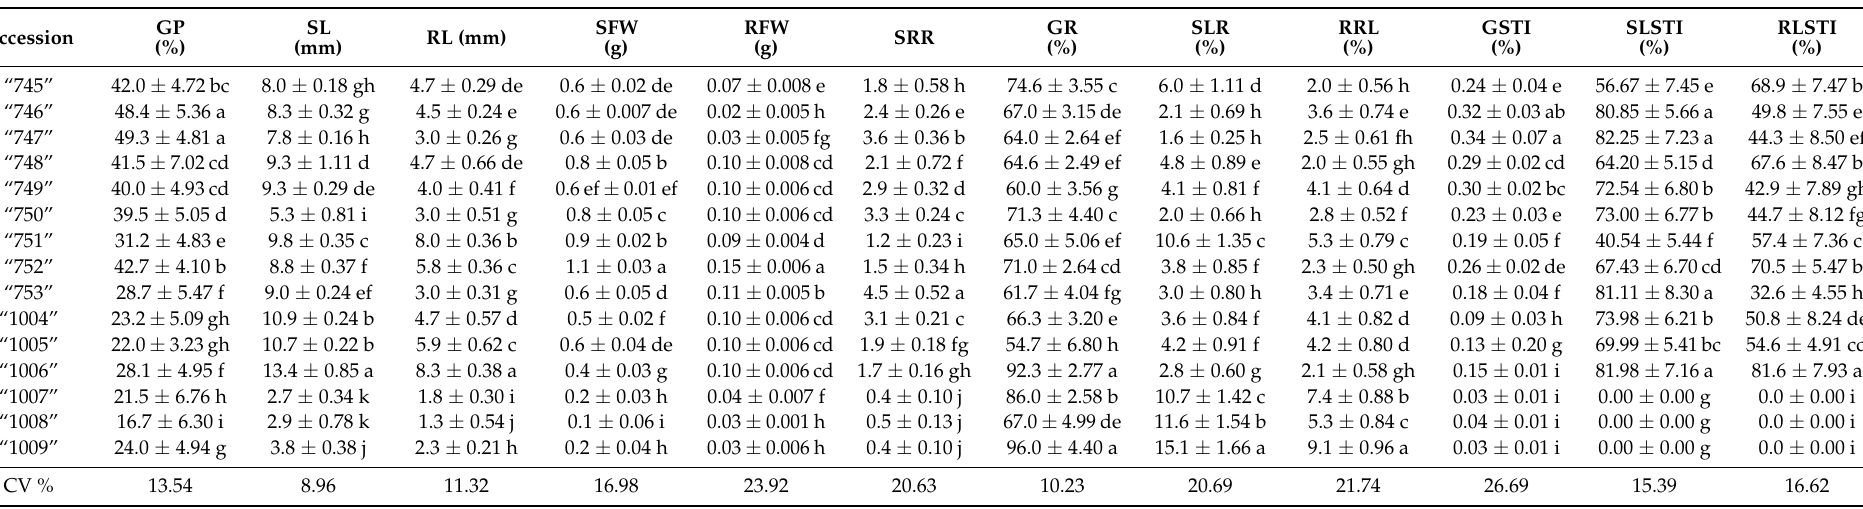
Table 3. The mean effect of the squash germplasm accessions on traits related to seed germination and seedling growth (mean ± SD), regardless of the salinity level (NaCl